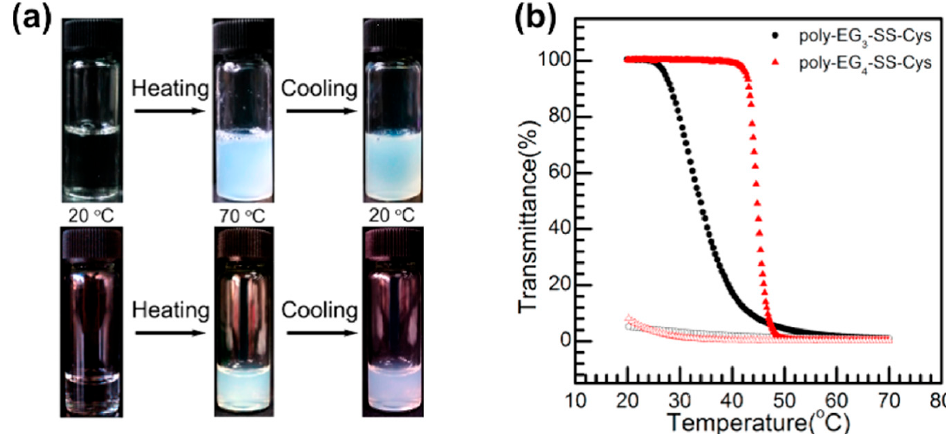
Figure 9. ( a ) Photos of temperature induced phase transition for poly-EG 3 -SS-Cys (top) and poly-EG 4 -SS-Cys (bottom) aqueous solutions at 2 mg/mL. ( b ) Transmittance as a function of temperature for aqueous solutions (2 mg/mL) of poly-EG 3 -SS-Cys (black) and poly-EG 4 -SS-Cys (red). Solid symbols: heating ramp. Open symbols: cooling ramp. Reproduced with permission [36]. Copyright 2014, American Chemical